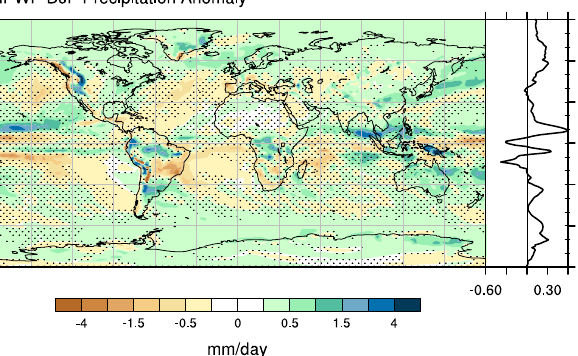
Fig. 3. CCSM4 simulated annual and seasonal mPWP surface tem- perature change ( ◦ C) from PI control; stippling indicates results are not statistically significant at 95% level. Zonally averaged temper- ature change (mPWP minus control) is plotted in the side panels.